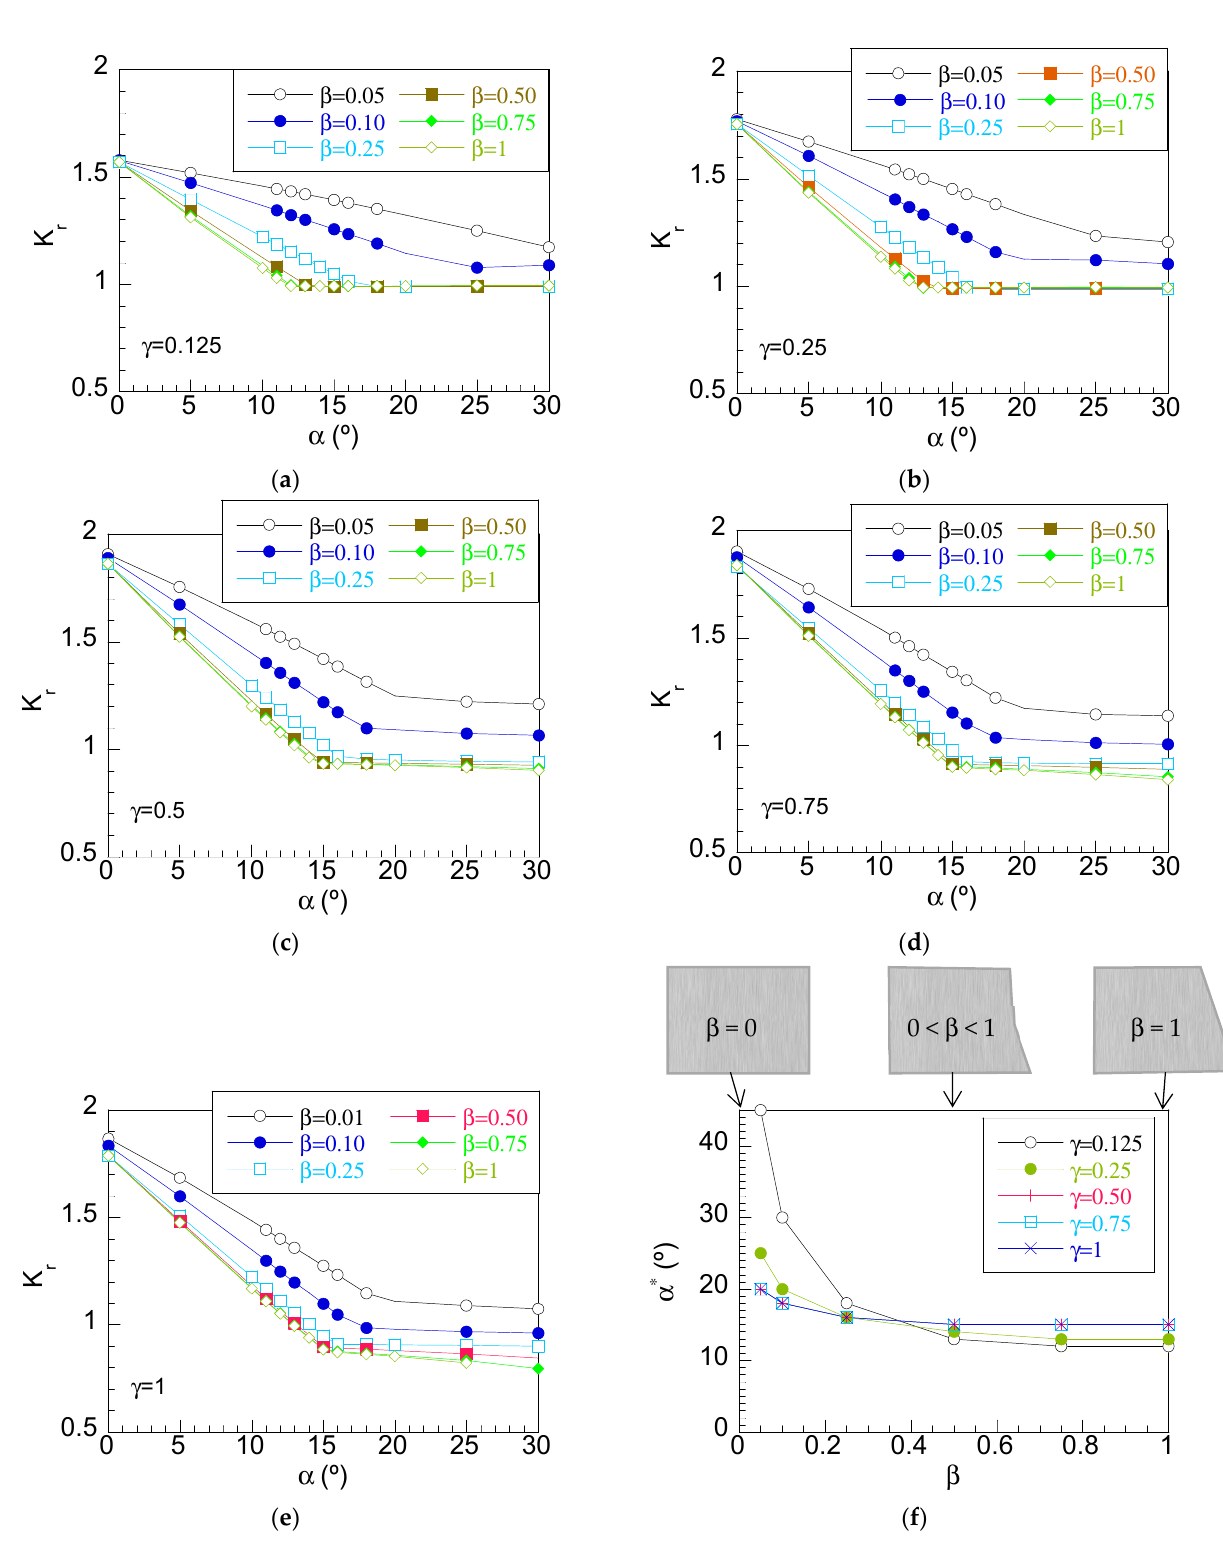
Figure 13. ( a – e ): Radial stress concentration factors as a function of β for different hub thicknesses and ( f ): variation of the transition chamfer angle with the chamfer height for diverse hub thicknesses.